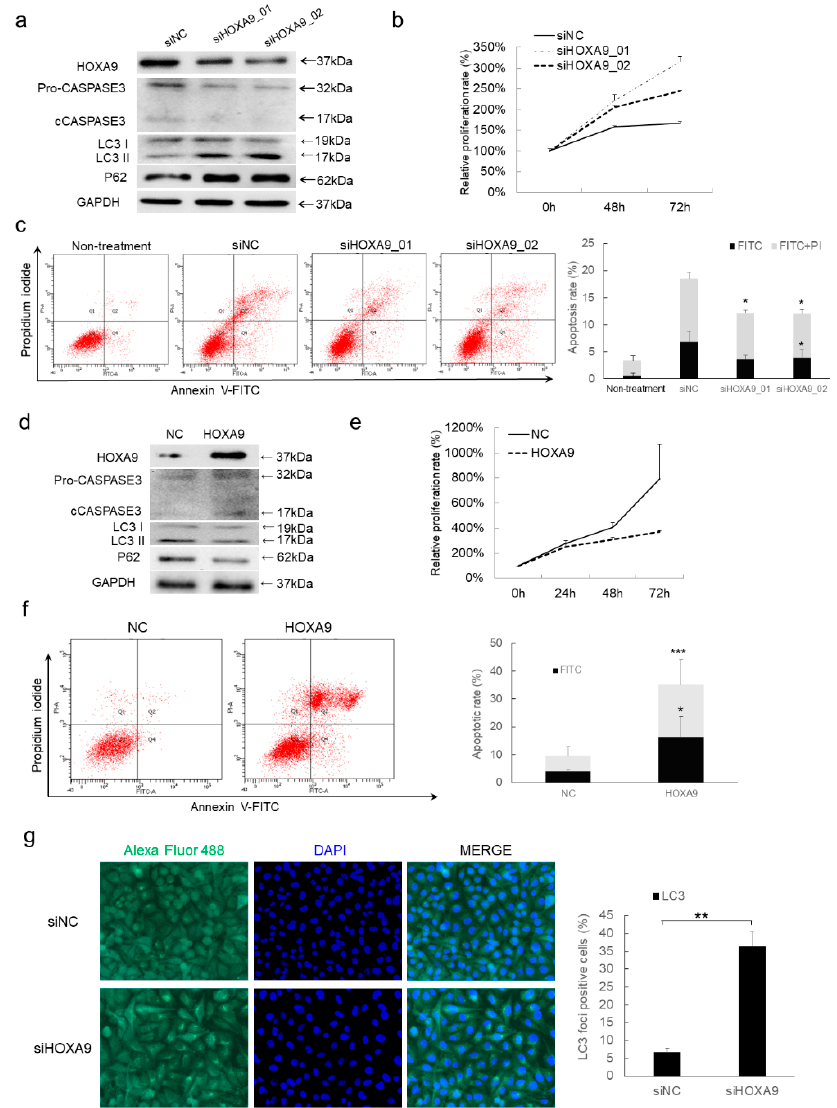
Figure 1. HOXA9 represses cell proliferation while promotes apoptosis in cSCC cells. ( a ) HOXA9 protein expression was detected after knockdown of HOXA9 by siRNAs in cSCC cells. Measurements of cell proliferation by CCK-8 assay ( n = 3) ( b ) and apoptosis assay by Annexin V / PI double staining ( n = 3) ( c ) were performed in cSCC cells treated with siRNAs targeting HOXA9. ( d ) HOXA9 protein expression was detected by western blot after overexpression of HOXA9 in cSCC cells. Measurements of cell proliferation by CCK-8 assay ( n = 3) ( e ) and apoptosis assay by Annexin V / PI double staining ( n = 3) ( f ) were performed in cSCC cells overexpressing HOXA9. ( g ) The autophagy in cSCC cells following HOXA9 knockdown was evaluated by LC3 staining. * p < 0.05, ** p < 0.01, *** p < 0.001.